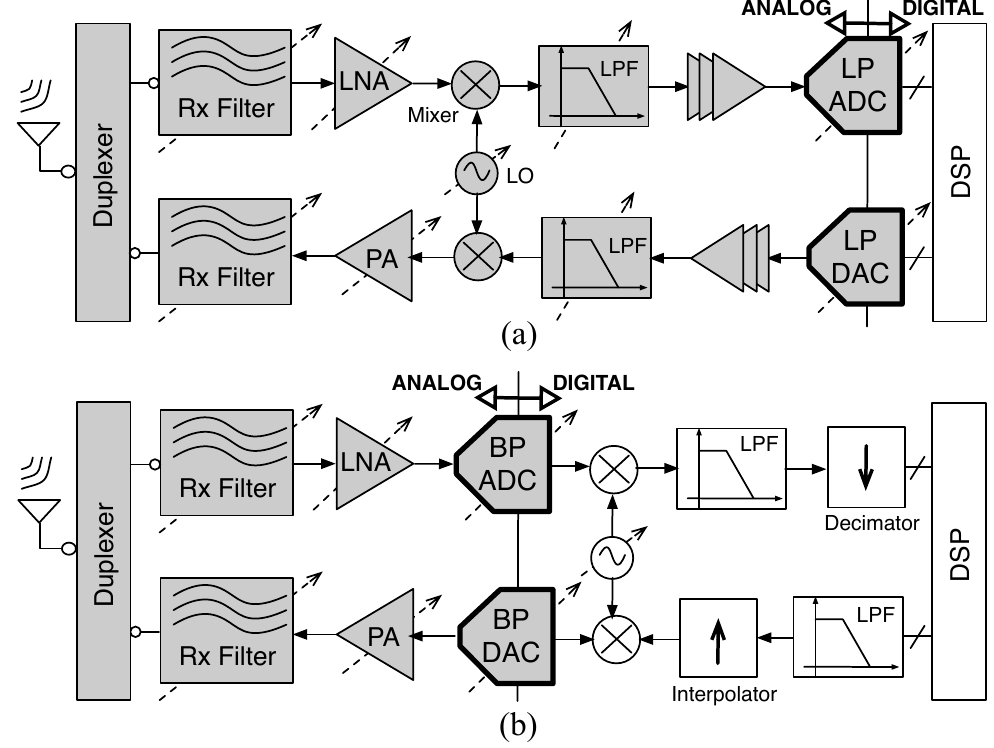
Figure 2. Conceptual diagram of reconfigurable RF transceivers based on the following: ( a ) Downcon- version to baseband. ( b ) RF-Digitization (quadrature mixers, not drawn for simplicity, are